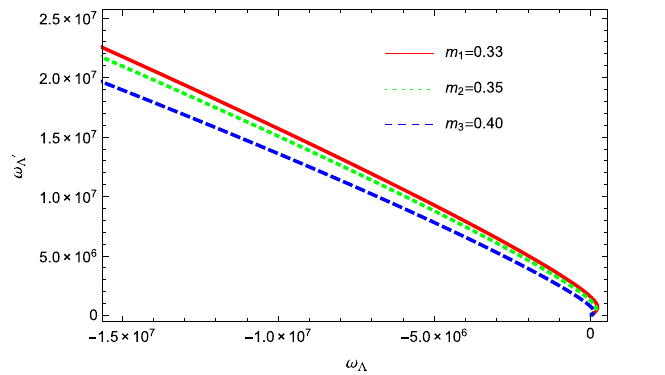
Fig. 19 Plots of intermediate ω (cid:3) − ω (cid:2) (cid:3) for u = 2 (left) and − 2 (right)